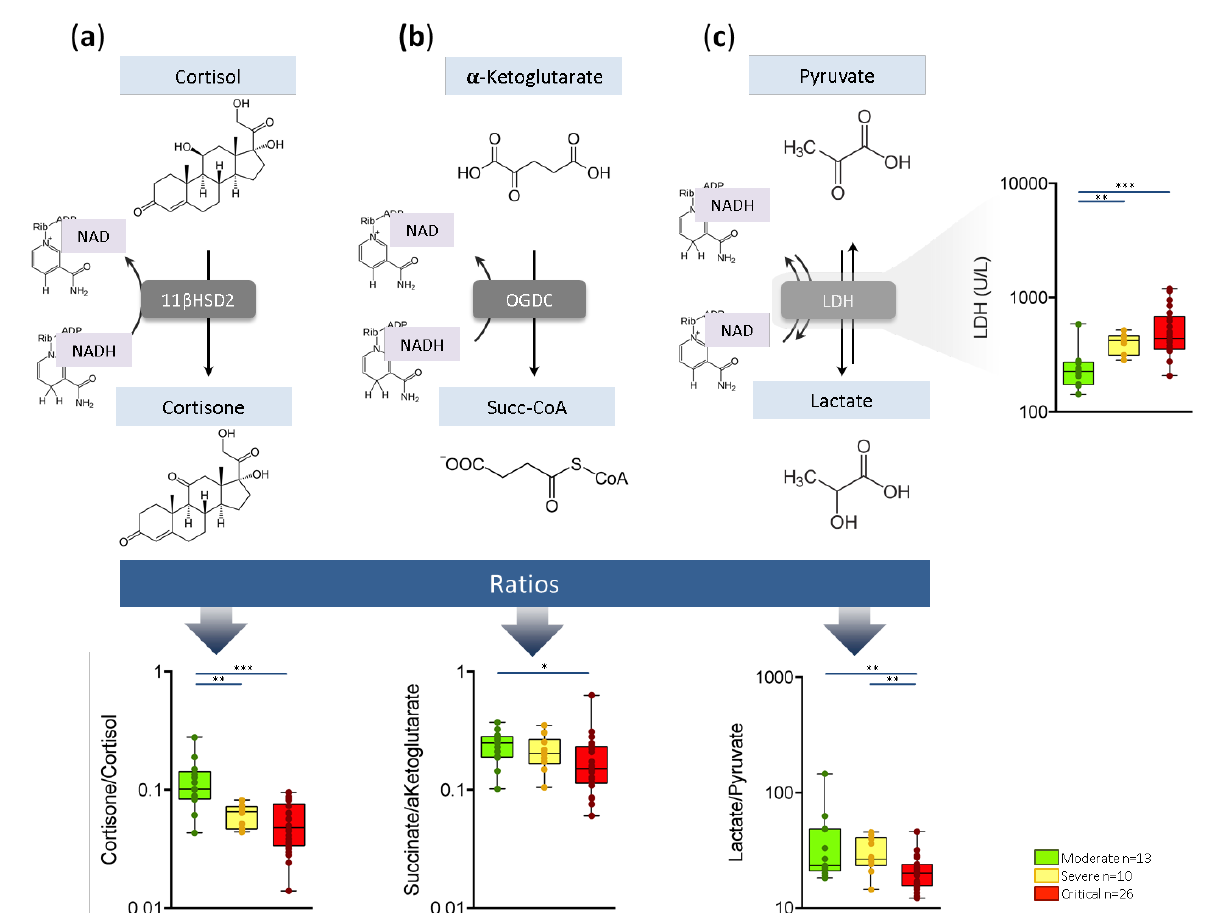
Figure 4. Metabolic pathways requiring NAD stratified according to the COVID-19 severity are represented by the ( a ) conversion of cortisol into cortisone via 11βHSD; ( b ) conversion of α-ketoglutarate to succinate via OGDC; and ( c ) production of LDH (estimated by the conversion of pyruvate into lactate). Abbreviations: 11βHSD: 11β-hydroxysteroid dehydrogenase; LDH: lactate dehydrogenase; NAD: nicotinamide adenine dinucleotide; OGDC: 2-oxoglutarate decarboxylase; Succ-CoA: succinyl-CoA. * p ≤ 0.05, ** p ≤ 0.01, *** p ≤ 0.001.